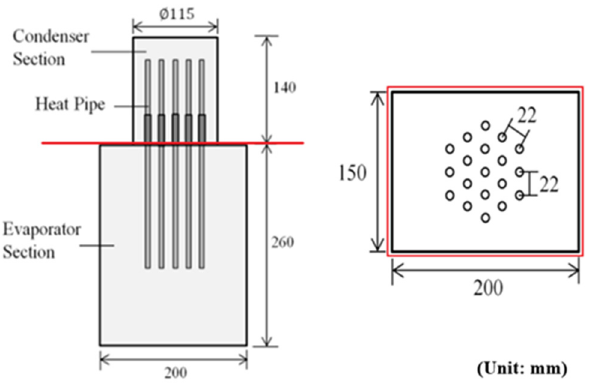
Figure 4. Cross-section of HPHE, showing the internal arrangement of heat pipes. In the experiment, the temperature of the fluid was read using a thermocouple wire connected to the temperature measurement module and recorded in the data acquisition system. The main temperature measurement points were located at the points where the hot gas and cooling water passed in and out of the heat exchanger, respectively. The heat exchanger was covered with cotton padding insulation to avoid heat loss and air convection interference. The layout of the experimental setup is shown in Figure 5.